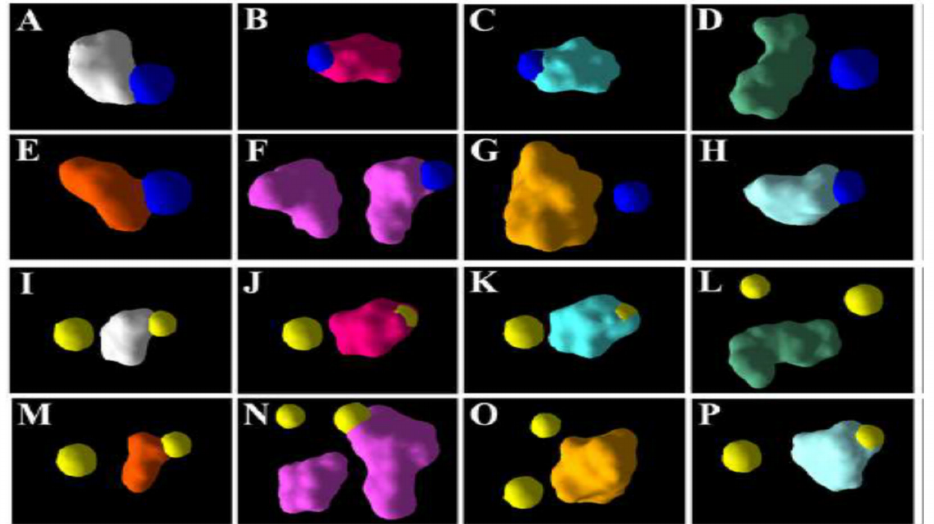
Figure 3. Electrostatic surfaces of the ions and metabolites and their overlaps in the case of Ta DHAR: ( A ) MDHA; ( B ) DHA; ( C ) AsA; ( D ) GSH; ( E ) SA; ( F ) 5-HT; ( G ) GA3; ( H ) IAA with Al 3+ . ( I ) MDHA; ( J ) DHA; ( K ) AsA; ( L ) GSH; ( M ) SA; ( N ) 5-HT; ( O ) GA3; ( P ) IAA with Mn 2+ . The dark blue and yellow spheres represent the electrostatic surfaces of Al 3+ and Mn 2+